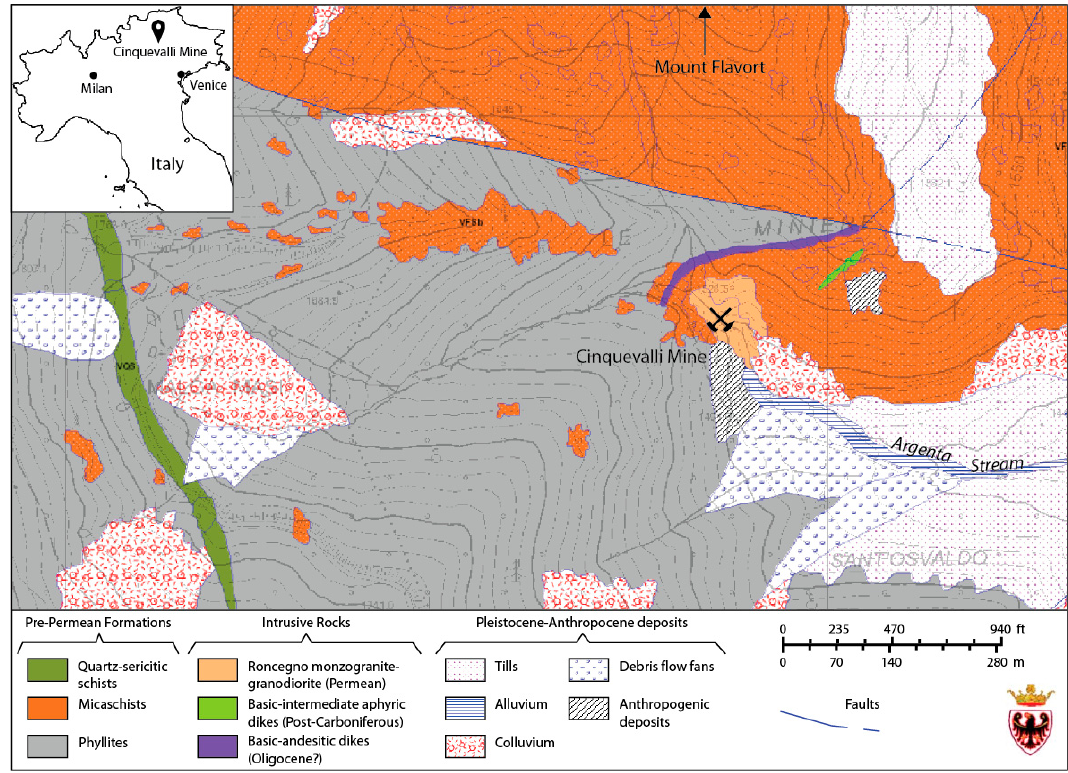
Figure 2. Localization and geological map of the Cinquevalli Mine area (elaborated from the on-line source [22]).